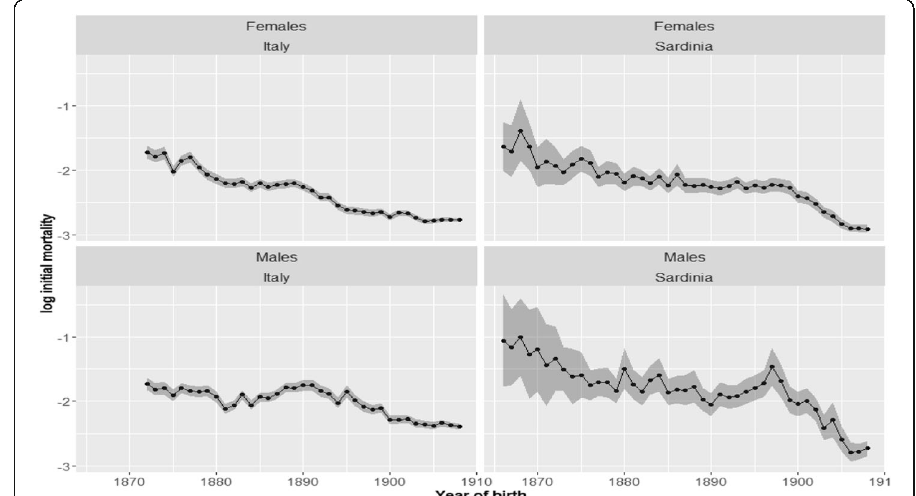
Fig. 6 Estimated initial mortality. Note : Each point represents the estimate of the α parameter of Eq. (1) for a given cohort. Source : ISTAT and